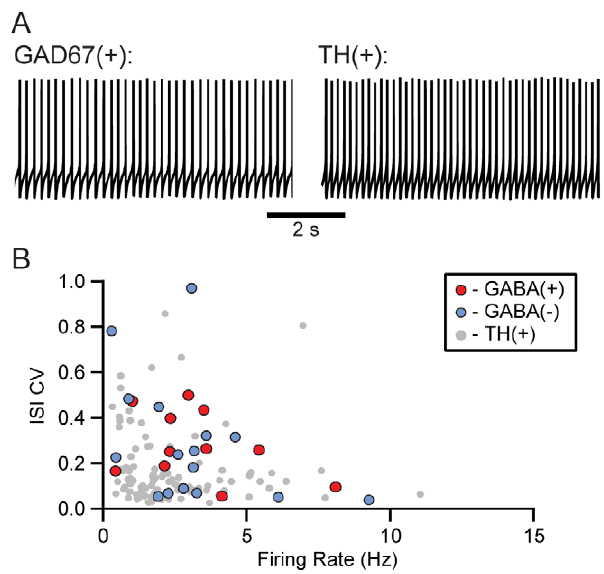
Figure 8. The spontaneous firing rates of VTA GABA neurons are similar to those of dopamine neurons exvivo . (A) Example traces of AP activity from a confirmed VTA GABA neuron (left) and a confirmed dopamine neuron (right) firing at similar frequencies. (B) For each spontaneously firing neuron, the ISI CV is plotted against the firing rate of the neuron.